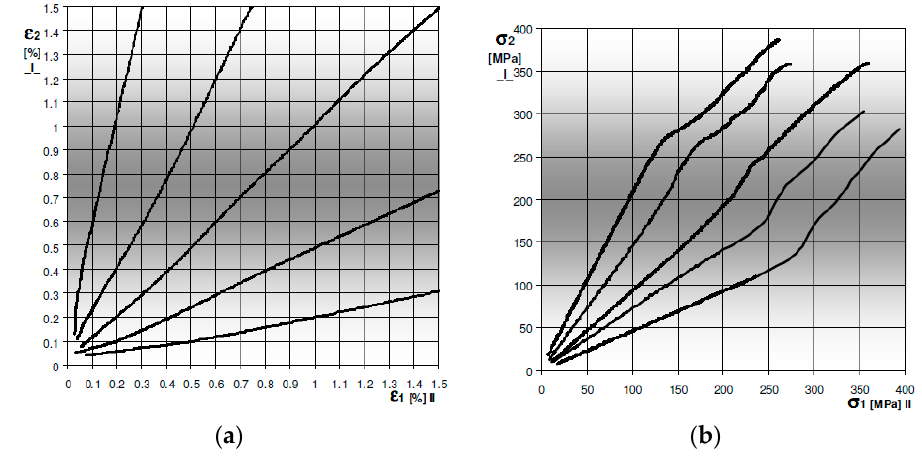
Figure 38. Addictions ( a ) ε 2 = ε 2 ( ε 1 ) ( b ) σ 2 = σ 2 ( σ 1 )